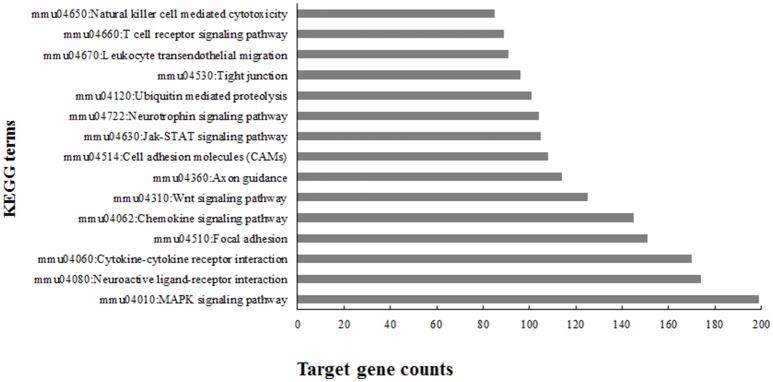
Top 15 enriched KEGG terms using predicted targets of differentially expressed microRNAs.